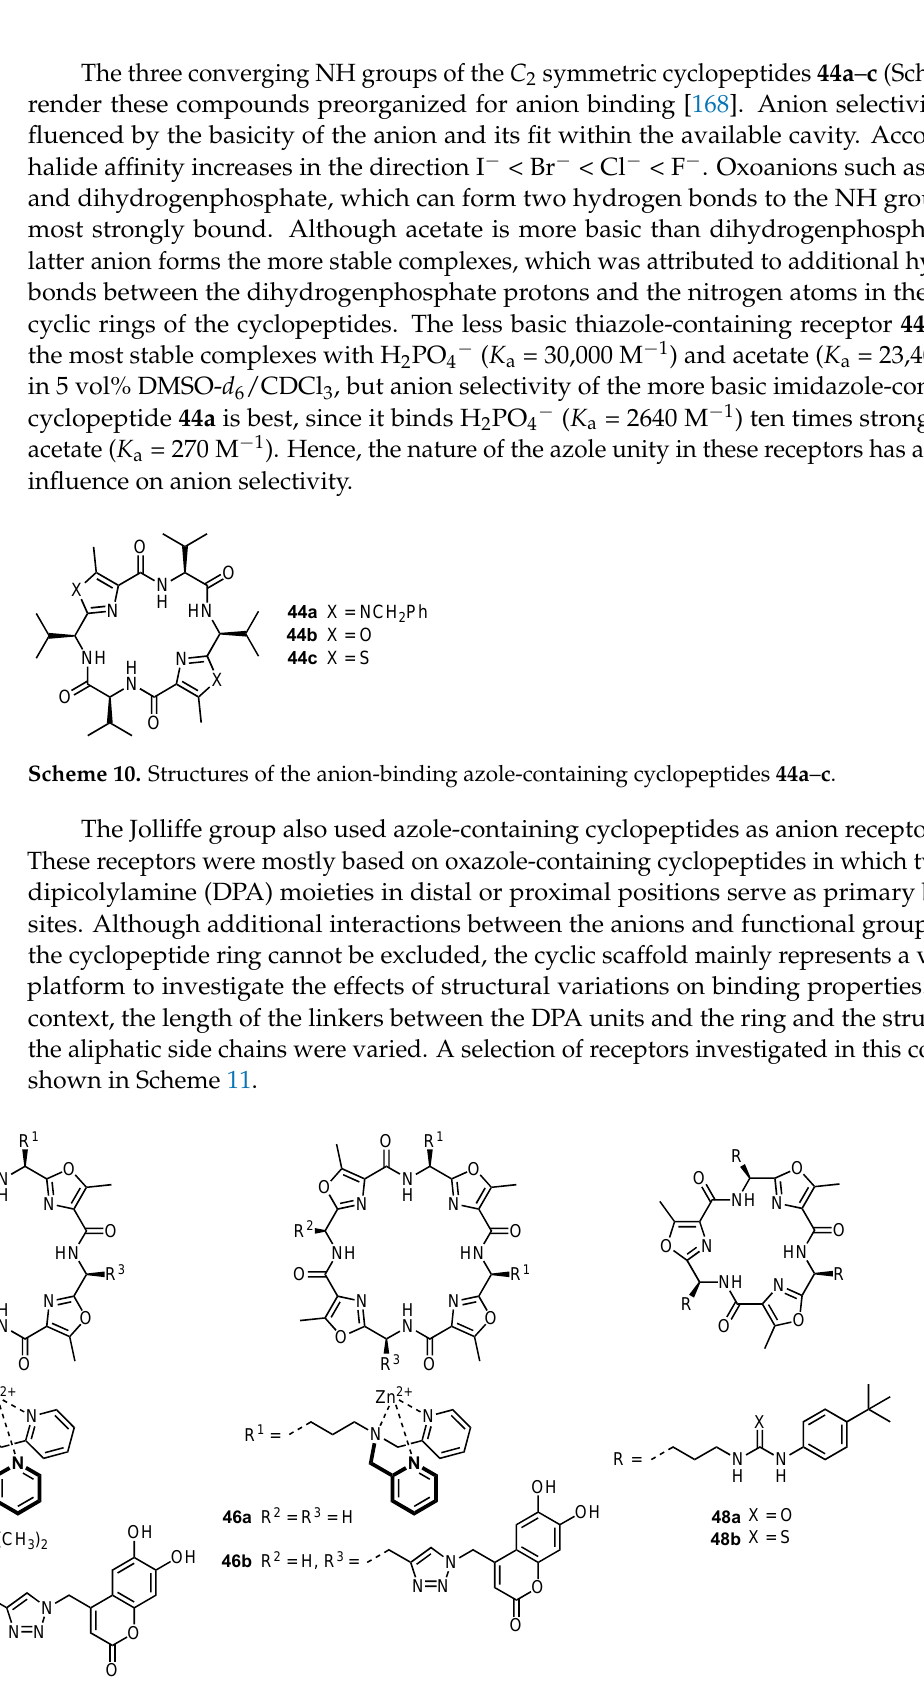
Scheme 11. Structures of the phosphate-binding cyclopeptides 45a – d and 46a , b containing zinc-DPA moieties, and 48a , b containing urea and thiourea groups in the side